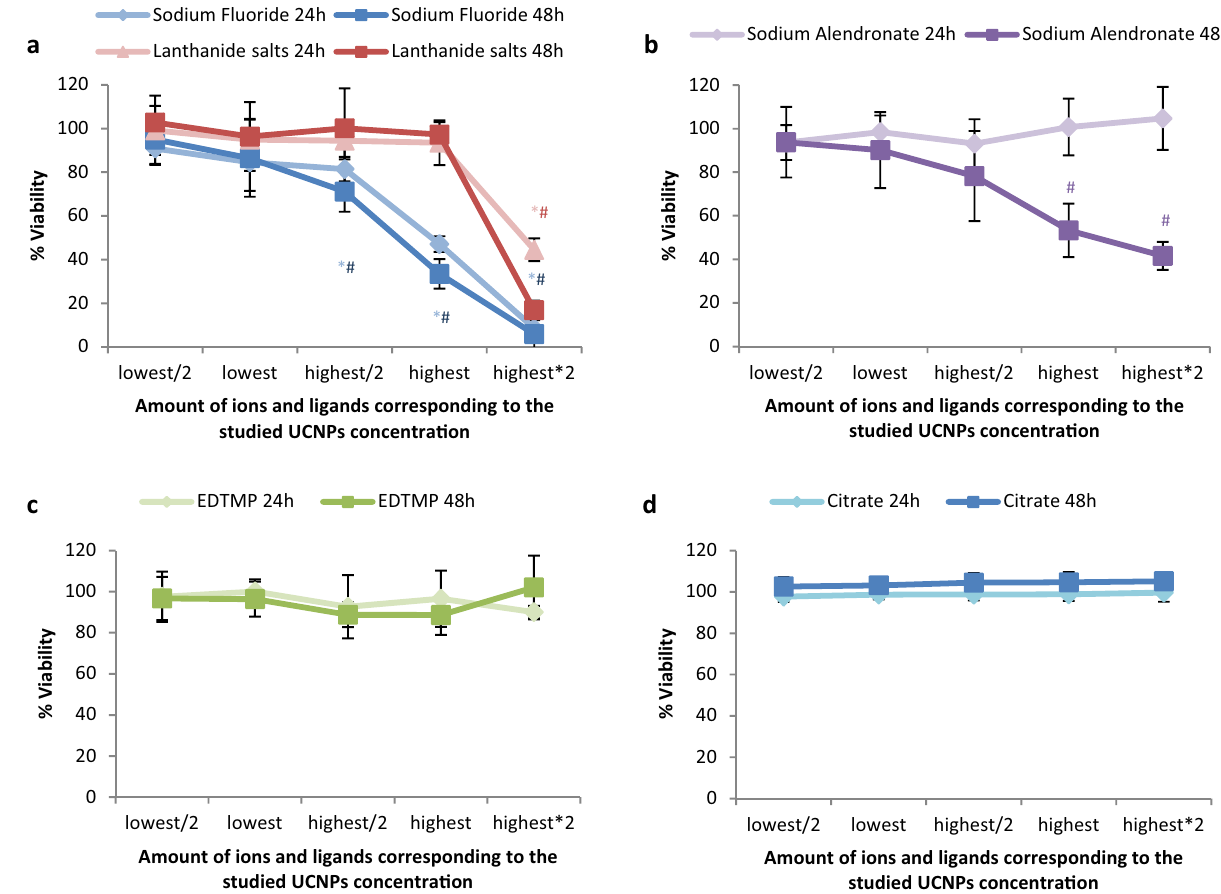
Figure 9. Viability of HaCaT cells after exposure to the UCNP constituting ions and ligands at concentrations matching the concentration range of released upon exposure of the UCNPs; the lowest amount (amount present in the 12.5 µg/mL of UCNPs), half of the lowest amount, half of the highest amount, highest amount (amount present in the 200 µg/mL of UCNPs), and twice of the highest amount. a) Sodium fluoride and lanthanide salts; b) Sodium alendronate; c) EDTMP; d) Citrate. The results are reported as mean ± standard deviation (SD) of 4 replicates from each of the 3 independent experiments for 24 h and 48 h. The differences were